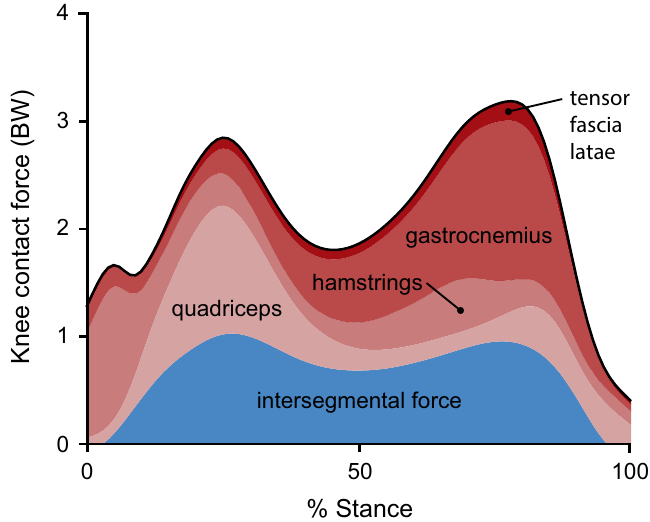
Figure 1. Contributions to knee contact force during walking. Muscle force contributions to knee contact force (red) exceed the intersegmental force contribution (blue), which is the reaction force from inverse dynamics. Muscle force contributions are dominated by the hamstrings during the first 10% of stance, the quadriceps from 10–40% stance, and the gastrocnemius from 40 to 90% stance. Forces are shown in terms of bodyweight (BW) for the 10 healthy subjects in this study, and muscle activations were estimated by minimizing the sum of squared activations using static